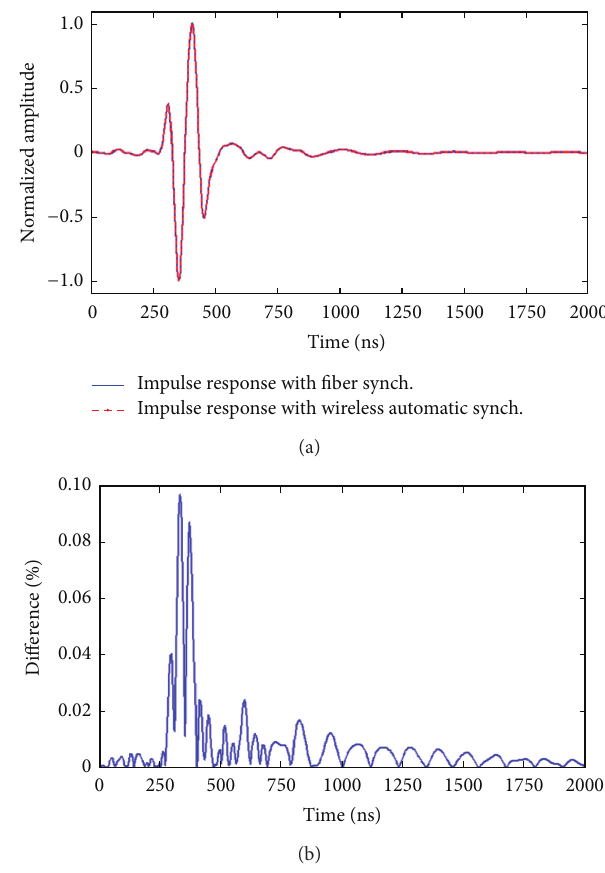
Figure 9: The obtained impulse responses with the two methods. (a) Two impulse responses. (b) The difference between them.